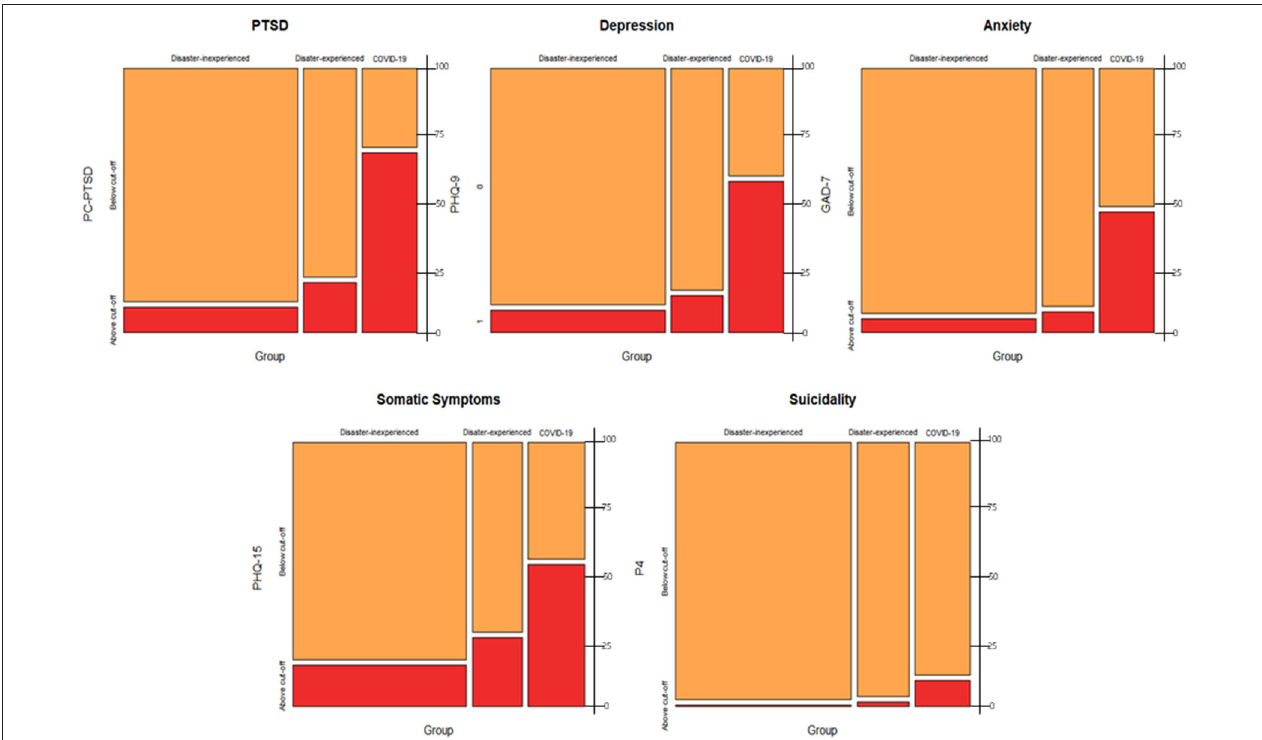
FIGURE 1 | Mosaic plots of severe mental health problems among COVID-19 patients and comparison groups. Mosaic plot depicting that the proportion of “above cut-off” group (red) for each of the mental-health-related variables in COVID-19 patients is significantly greater than that in the control groups. PC-PCSD, Primary Care PTSD Screen; PHQ-9, Patient Health Questionnaire-9; GAD-7, Generalized Anxiety Disorder; Screener P4, P4 suicidality